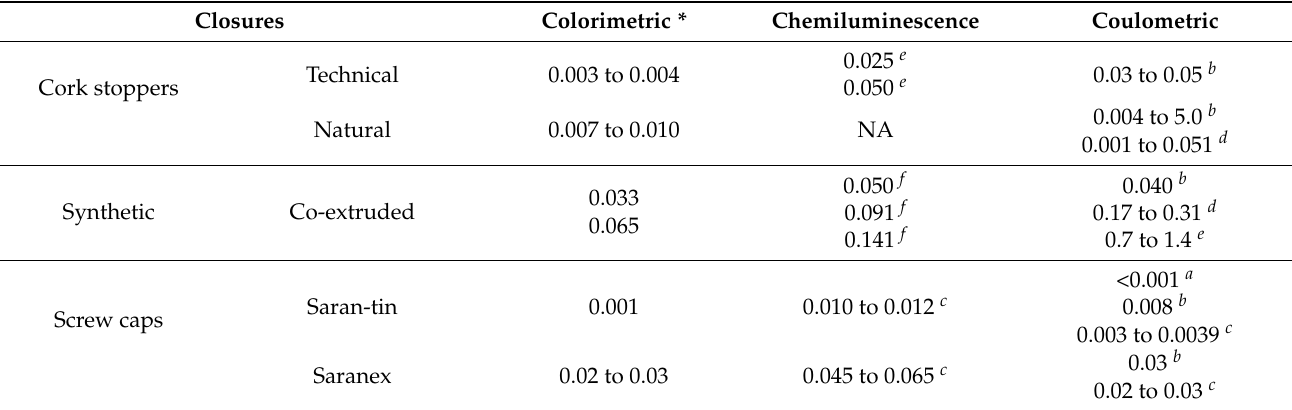
Table 1. General overview of oxygen transmission rate (OTR) values (mg/closure/month) obtained or recalculated from the literature for the main wine